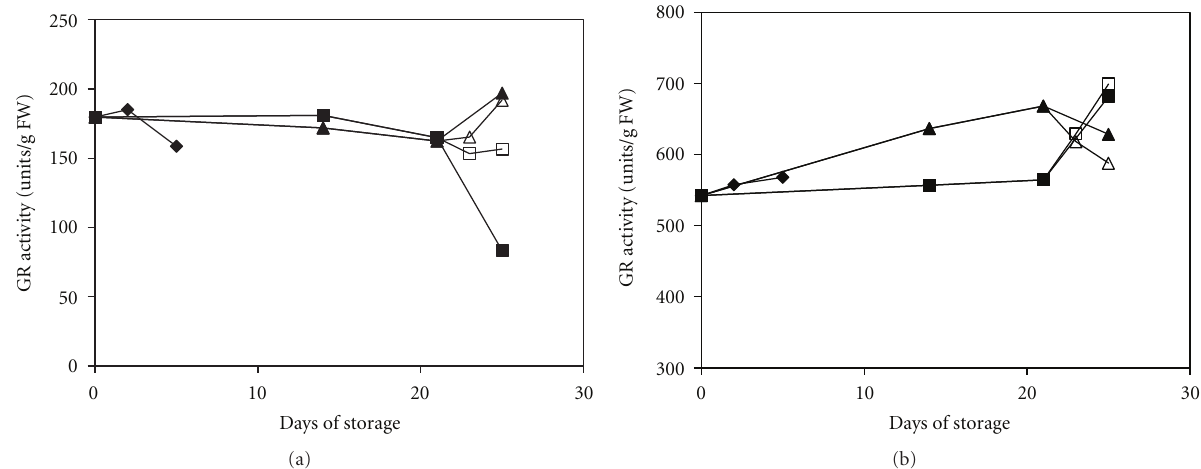
Figure 6: Changes in the GR activity of mature green peppers (a) and fully ripe/red peppers (b) for the UCRT ( (cid:2) ), MAP ( (cid:3) ), and MAP+1- MCP ( (cid:4) ) treatments during storage at 10 ◦ C; MAP ( (cid:5) ) and MAP+1-MCP ( (cid:6) ) values for the fruits transferred to room temperature at day 21. The values are the means of six replicate samples, and their S.E.s are shown.